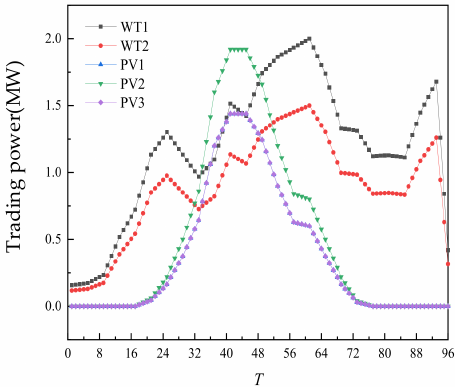
Figure 6. Day-ahead trading of WT and